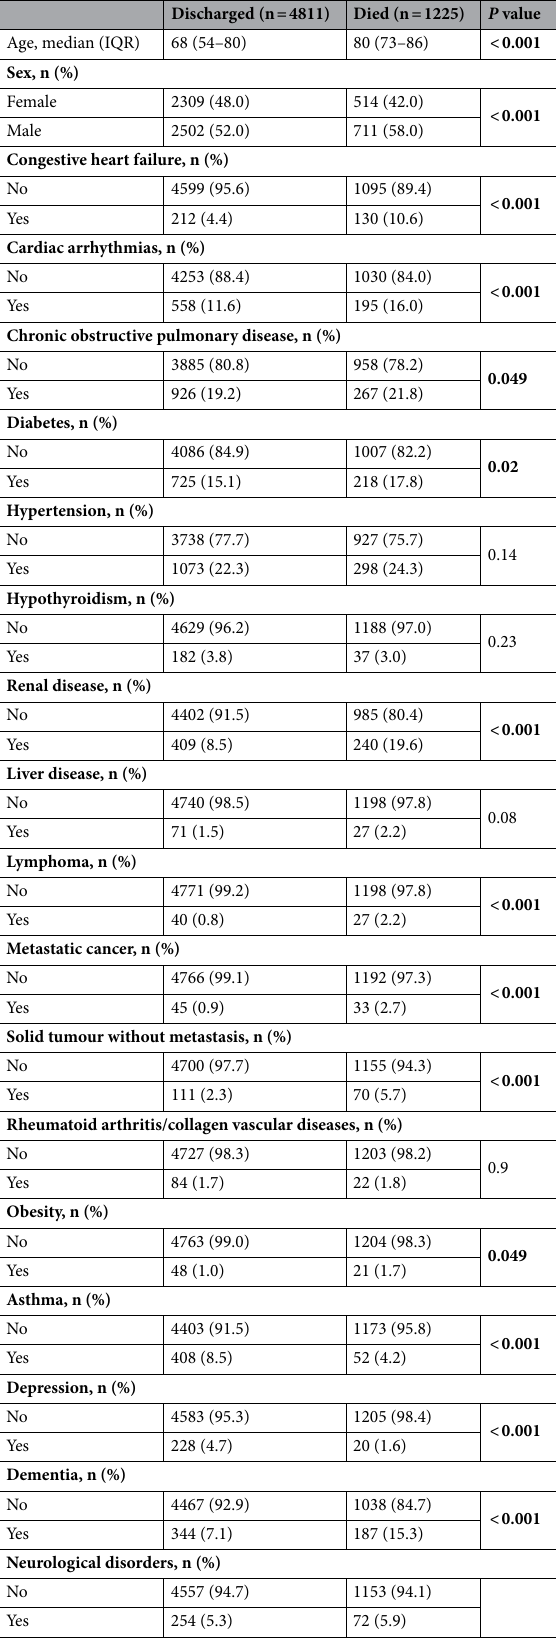
Table 1. Demographic and clinical characteristics of patients. Statistically significant P < 0.05 values are in